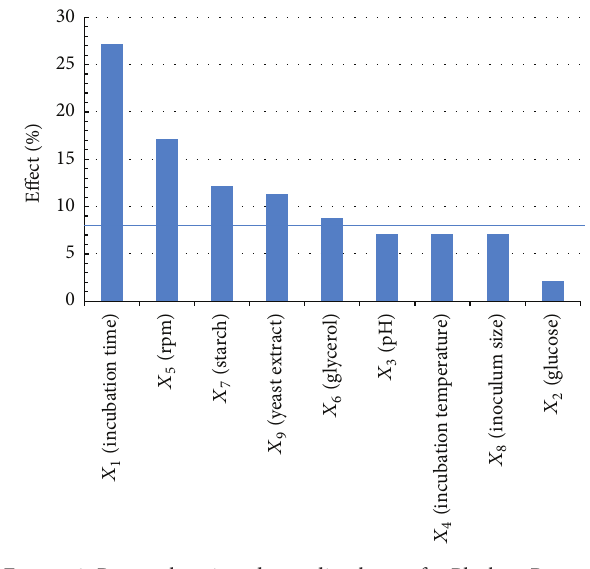
Figure 3: Pareto chart in a descending layout for Plackett-Burman parameter estimates of nine tested independent